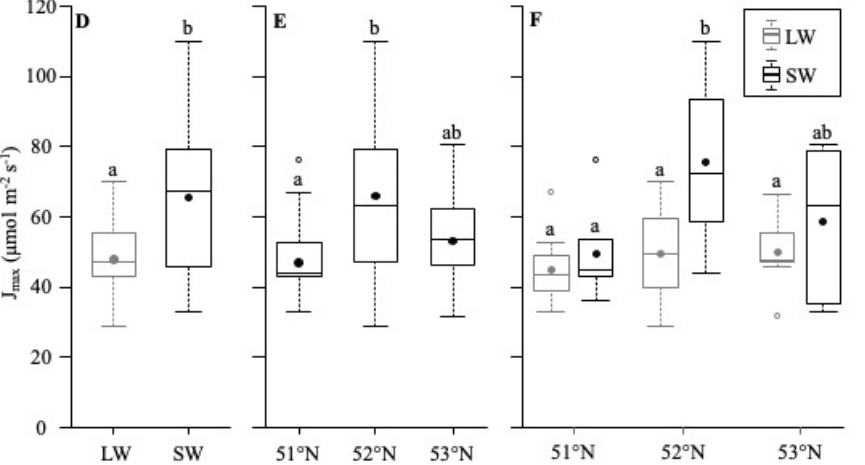
Figure 3. Maximum Rubisco carboxylation rate (V cmax , ( A – C )) and maximum electron transport rate (J max , ( D – F )) averaged for trees in SMs and LWs for all latitudes ( A , D ), the different latitudes sampled ( B , E ), and the interaction between stand type and latitude ( C , F ). Solid points and letters represent the mean and significant differences from the 5% level (Tukey test), respectively.